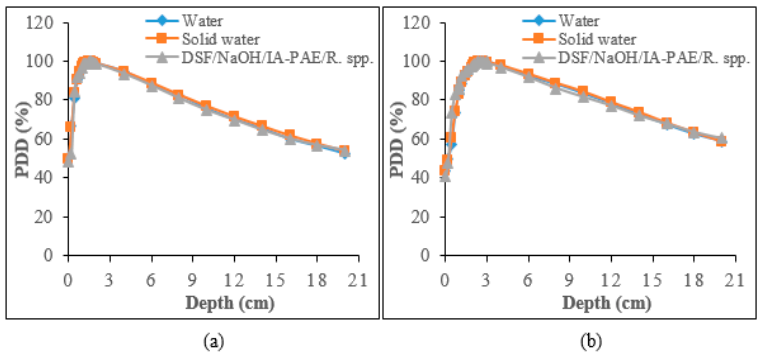
Figure 7. PDD plots with the use of EBT3 film for water, solid water, and DSF/NaOH/IA-PAE/ R. spp. particleboard phantoms ascertained for: ( a ) 6 MV and ( b ) 10 MV photons.